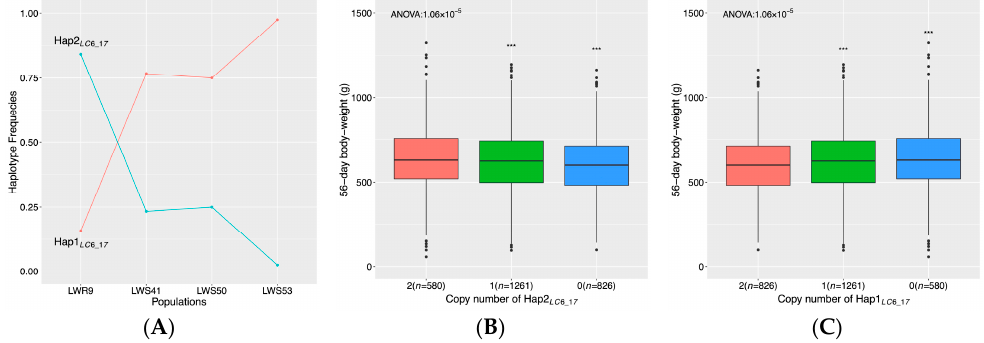
Figure 3. Purging regions in the LW lineage with associations to 56-day body weight. The